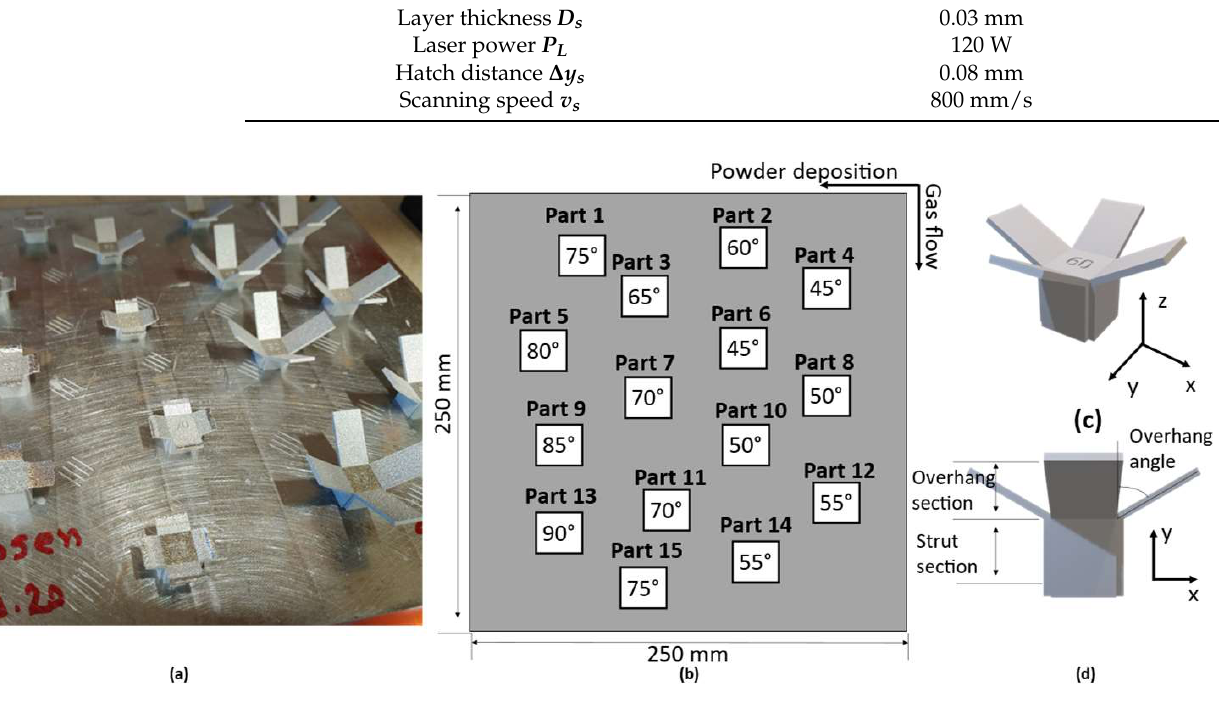
Figure 4. ( a ) Printed parts for training data set; ( b ) orientation of printed part on building platform of EOS M290; ( c ) design of part 2 with 60° overhang angle; ( d ) front view of designed part 2. Table 3. Layer height of printed